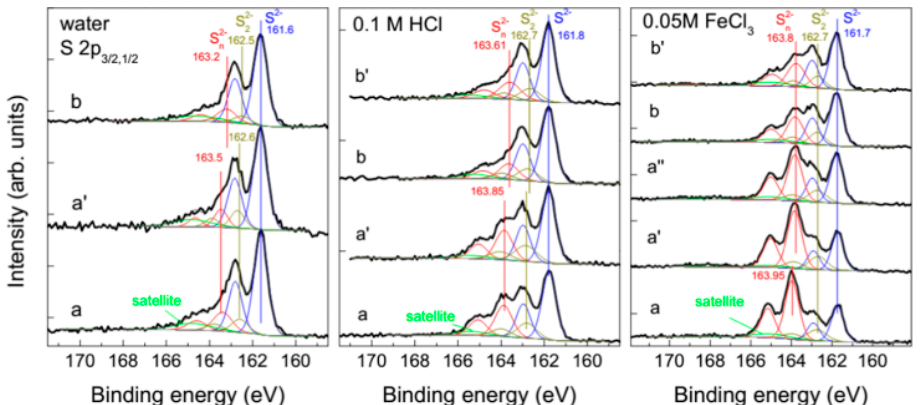
Figure 1. X-ray photoelectron S 2p spectra of particulate chalcopyrite conditioned in water, 0.1 M HCl, and 0.05 M FeCl 3 + 0.01 M HCl, centrifuged, fast-frozen and measured at − 160 °C (a, a ′ ), − 40 °C (a ″ ), and +25 °C (b, b ′ ). The spectra a ′ and b ′ measured employing an electron flood gun. Reproduced from [67] with permission from ACS.